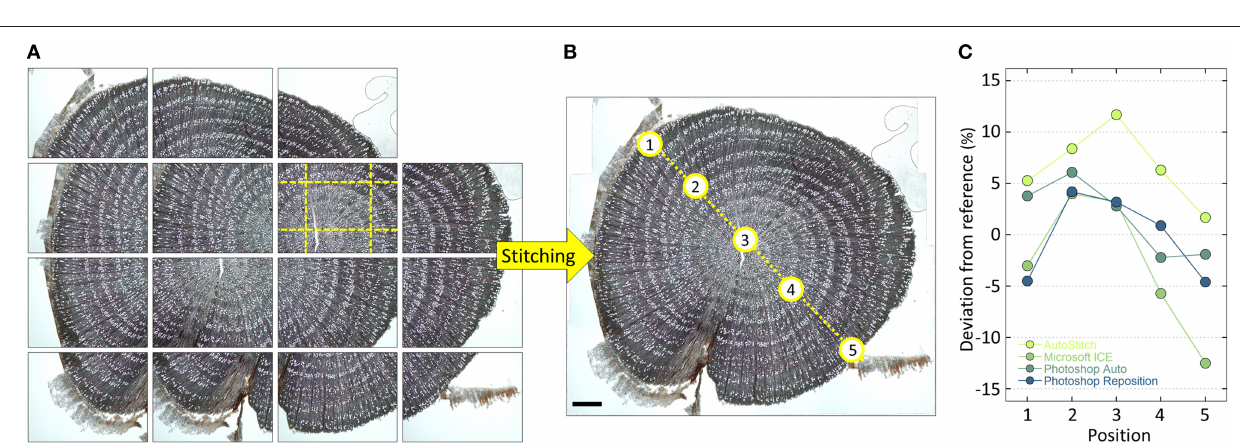
FIGURE 8 | (A) Overlapping high-resolution images stitched together using PTGui and (B) the obtained high-resolution image of an entire Verbascum thapsus root cross-section. The used overlap with neighboring images is visualized for one of the images with yellow dashed lines in (A) . The input images contained distortions introduced by the used optical system, which were successfully removed by PTGui (verified by creating a composite image of a stage micrometer and measuring the distances between tick marks, which yielded constant values throughout the image). Five randomly selected vessels along a transect (see labels in B ) having an lumen area between 100 and 3500 µ m 2 were subsequently measured using ROXAS ( Table 1 ) using always the same settings in images stitched with the software PTGui, AutoStitch, Microsoft Image Composite Editor and Photoshop (Automatic and Reposition settings). Panel (C) shows the percentage deviation of the obtained values compared to the PTGui reference values. The values in all used stitching tools and settings deviate from the PTGui reference, thus indicating distortions. In addition, the magnitude of the deviations varied along the transect often changing from over- to under-estimation. Note that Photoshop Reposition setting also produces distortion-free images if input images are already distortion-free, while AutoStitch still introduces distortions. Scale bar =